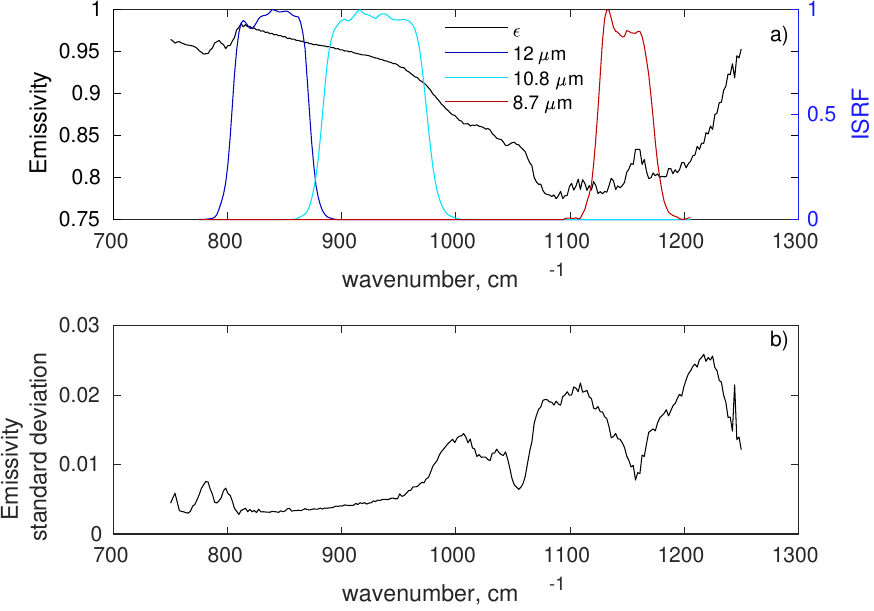
Figure 6. ( a ) Mean in situ emissivity spectrum and the ISRF of the three SEVIRI atmospheric window channels in the Thermal Infrared; ( b ) standard deviation of in situ